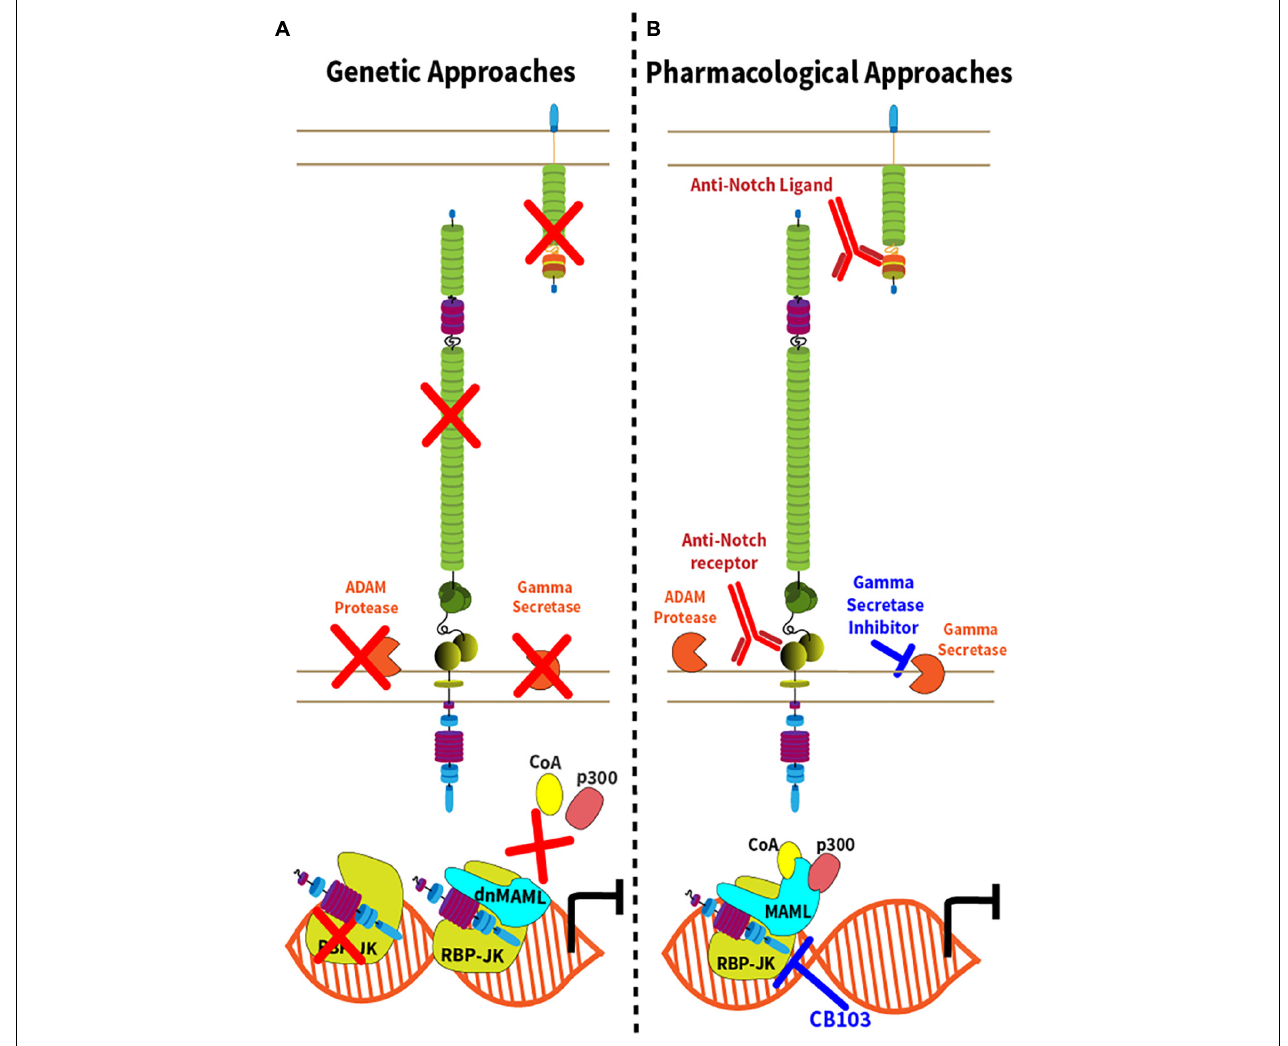
FIGURE 2 | Genetic and pharmacological approaches to Notch inhibition. (A) Genetic inactivation strategies leading to inhibition of the Notch signaling pathway are represented by red “X” with the exception of dnMAML, where the red “X” depicts the disruption of the Notch transcription activation complex due to expression of a truncated, dominant negative (dn) form of MAML1. In addition to conditional expression of dnMAML, commonly used approaches include conditional inactivation of Notch ligand genes, Notch receptor genes, Adam10 , genes encoding components of the γ -secretase complex or Rbpj ; (B) Strategies of pharmacological inhibition of Notch signaling either though the administration monoclonal antibodies targeting the Notch ligands or receptors, or small molecule inhibitors. γ -secretase inhibitors target components of the γ -secretase complex. CB-103 inhibits the Notch transcription